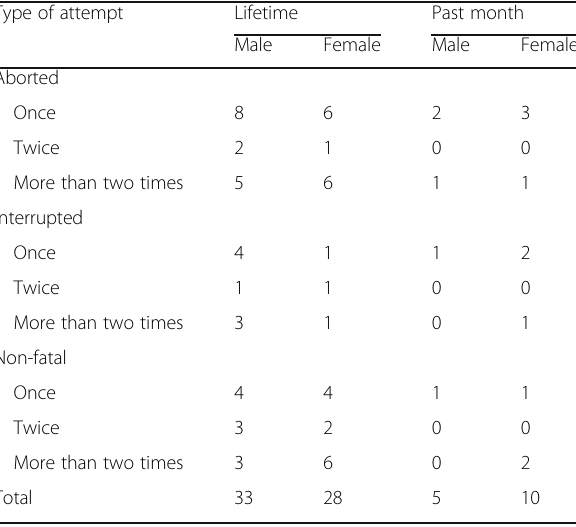
Table 4 Number of lifetime and past month aborted attempt, interrupted attempt, and non-fatal suicide attempt among surveyed ALS learners according to sex Type of